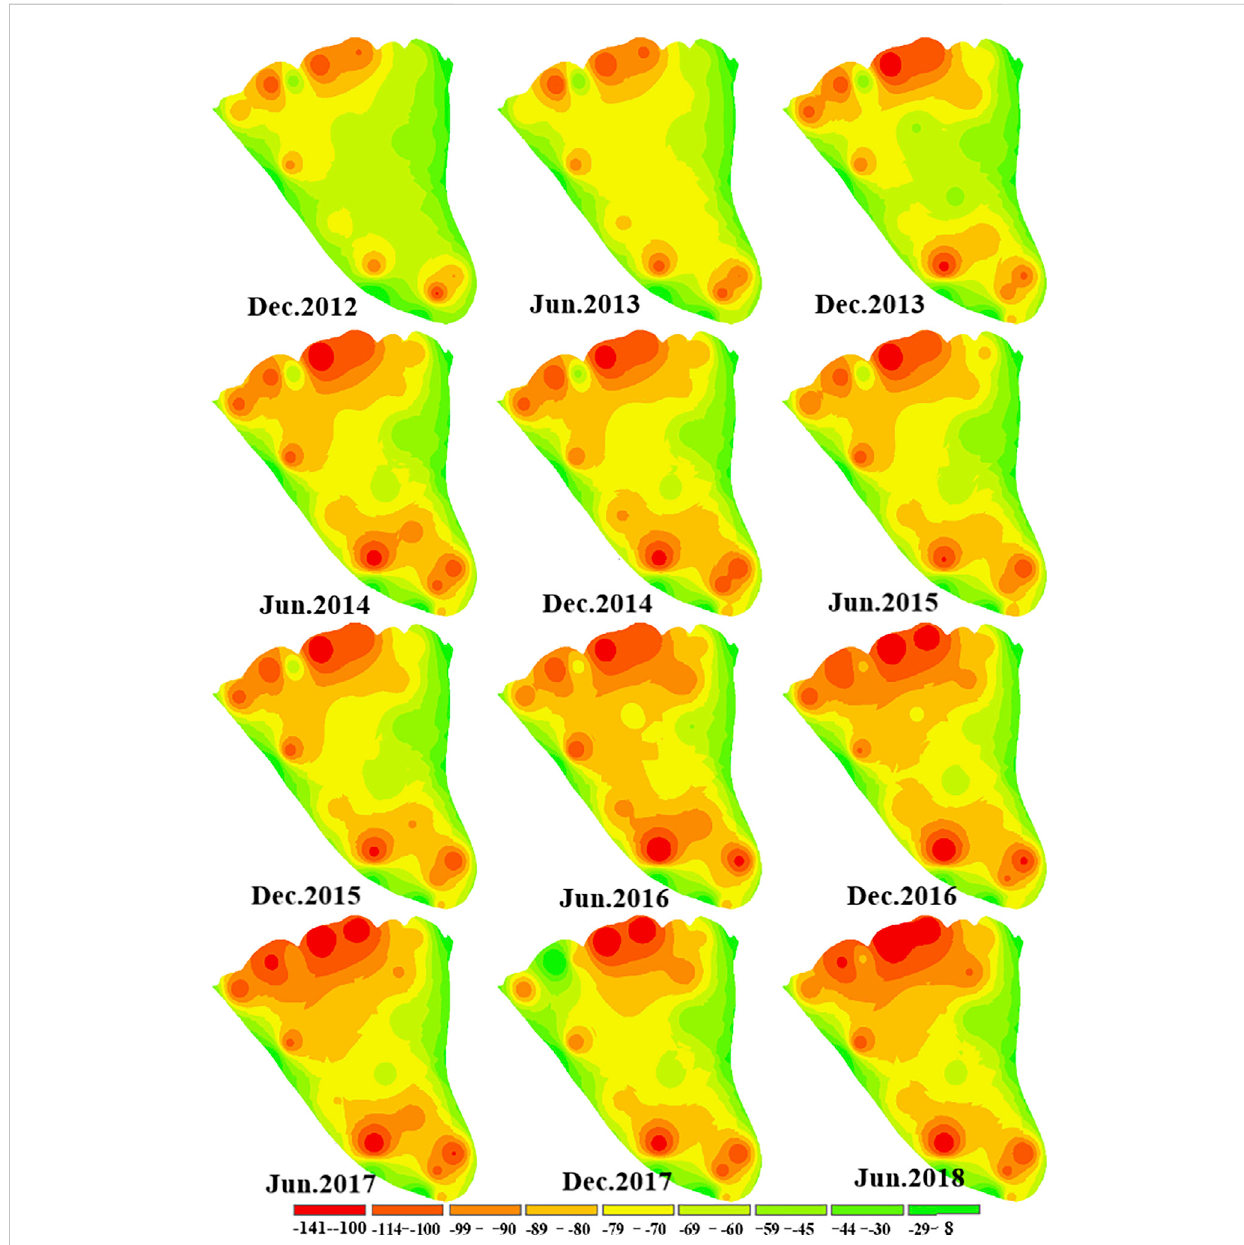
FIGURE 9 Spatial and temporal evolution nephogram of vertical